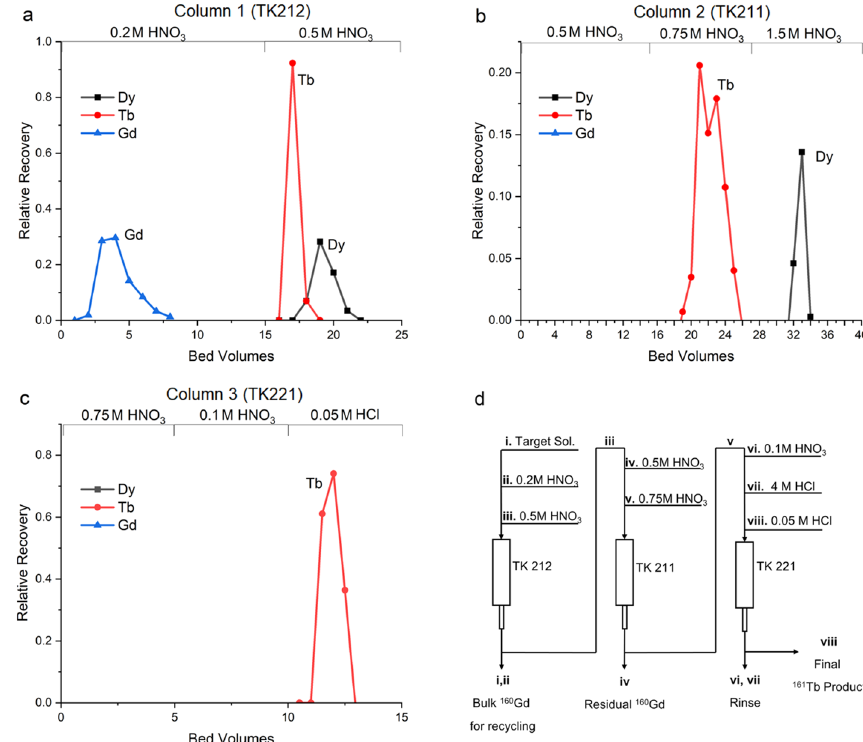
Fig. 3 Elution profile of Gd, Tb, and Dy (10 mg, 1 mg, and 1 mg respectively) TK212 ( a ), TK211( b ) and TK221 ( c ). Tb containing fractions were combined for loading on the next column to simulate purfication run. Column bed volumes were 1 mL for each column during cold test but were later optimized for active runs. Overall process diagram ( d ) note steps i–v can be performed automactically, while steps vi–viii must